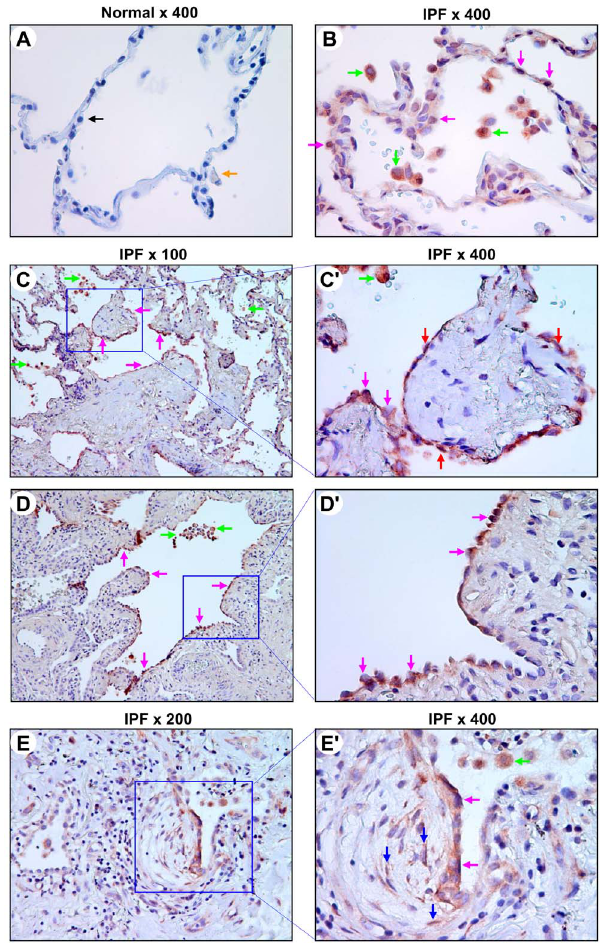
Figure 2. Expression of PKD1 in normal and IPF alveoli. Normal and IPF lung sections were subjected to immunohistochemical analysis by a PKD1 specific antibody PKD1 (A-20) at a dilution of 1:500. A: normal lung AECs (black arrow) and macrophages (orange arrow) were negative for PKD1. Final magnification: 6 400. B: in non-fibrotic areas of IPF lung alveoli, PKD1 (red) were expressed in the cytoplasm and nuclei of macrophages (green arrows) and AECs, including type II pneumocytes (pink arrows). Final magnification: 6 400. C–D 9 : in the fibrotic areas of IPF lung, PKD1 (red) was expressed in flat (red arrows) and cuboidal (pink arrows) regenerative AECs lining remodeled fibrotic alveolar septa and/or fibroblast foci. Strong PKD1 immunoreactivity was also observed in macrophages (green arrows). The regions indicated in panels C and D ( 6 100) are shown at higher magnification in C 9 and D 9 ( 6 400). E and E 9 : PKD1 (red) were expressed in some fibroblasts or myofibroblasts (blue arrows) in fibroblasts foci of IPF lung and in regenerative AECs (pink arrows) covering the fibroblast foci as well as in macrophages (green arrow). The region indicated in panel E ( 6 200) is shown at higher magnification in D 9 ( 6